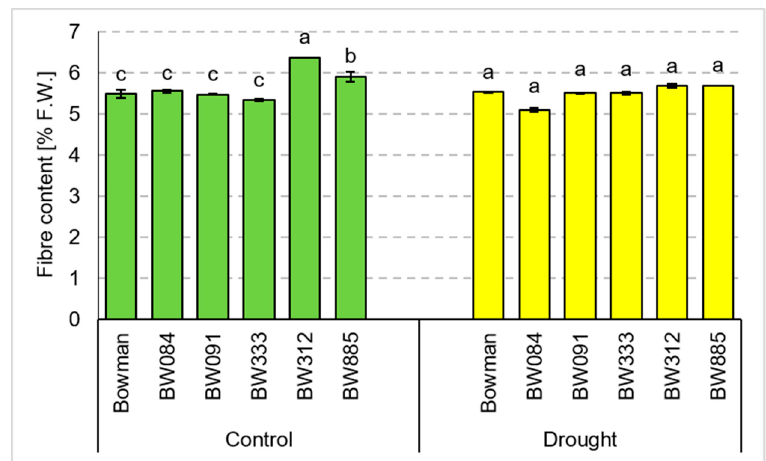
Figure 10. Contents of fiber in grains of the analyzed genotypes under the optimal watering (control) conditions and after the drought stress (the pot experiment). The mean values ± (SD) marked with the same letters (separately for the control and drought-stressed plants) are not significantly different, according to Duncan’s test ( p ≤ 0.05). Details are given in the text.